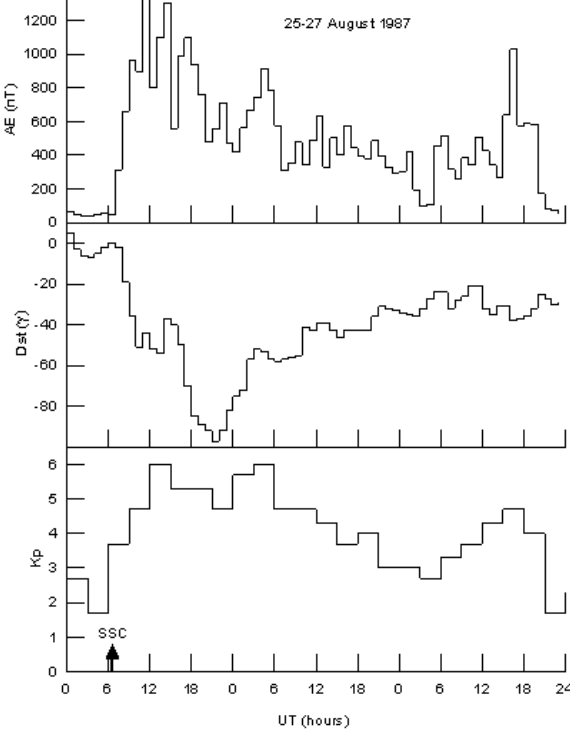
Fig. 1. The bottom and middle panels show diurnal variations of the Fig. 2. The variation in the AE index (top panel), the D st index zonal electric field during 25–27 August 1987. The solid line in the (middle panel), and K p index (bottom panel) during 25–27 August bottom panel shows the F -region storm-time equatorial zonal elec- 1987. The SSC onset of the geomagnetic storm is shown by the tric field found from the empirical model of Fejer and Scherliess arrow in the bottom (1997), while the F -region geomagnetically quiet equatorial zonal electric field found from the empirical model of Scherliess and Fe- jer (1999) is presented by the dashed line in the bottom panel. For the time periods from 16:30 UT to 21:00 UT on 25 August, the empirical electric field, given by the solid line in the bottom panel, is modified by use of the comparison between the measured and modeled values of hmF 2 over the Manila sounder (see Sect. 4.1). The resulting storm-time equatorial zonal electric field, E ES , given 3 by crosses in the bottom panel of Fig. 1, is used in the model cal- culations at the F -region altitudes over the geomagnetic equator. The average quiet time value of the zonal electric field at the F - region altitudes over Arecibo (dashed line in the middle panel) is found from Fejer (1993). To find the disturbed zonal electric field, E AS , at the F -region altitudes, 29 ◦ geomagnetic latitude, and 201 ◦ 3 geomagnetic longitude, we find the difference, 1 E 3 , between the disturbed (crosses in the bottom panel) and geomagnetically quiet (dashed line in the bottom panel) zonal electric field. We suggest that the studied storm-time variations in the zonal electric field at the F -region altitudes are the same at the geomagnetic equator and at 29 ◦ geomagnetic latitude, i.e. E AS =E AQ + 1 E 3 . The E AS used 3 3 3 is shown by crosses in the middle panel. The F -region plasma ver- tical drift velocity, measured by the Jicamarca, radar from 16:31 UT on 26 August 1987, to 20:45 UT on 27 August 1987, is displayed by triangles in the top panel, while the F -region plasma vertical drift velocity over Jicamarca calculated by the empirical model of Fejer and Scherliess (1997) for the time period of 25–27 August 1987 is shown by the solid line in the top panel.